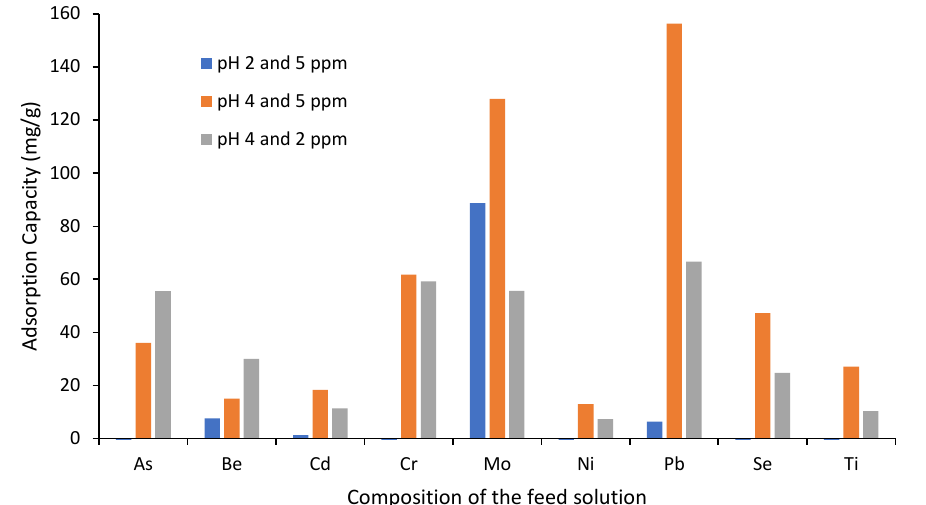
Figure 18. Adsorption capacity of CDC toward various metals in a multicomponent aqueous solution (the heavy metal concentrations were 2 and 5 ppm at pH 2 and 4; CDC loading: 0.6 g/L; agitation speed: 150 RPM.